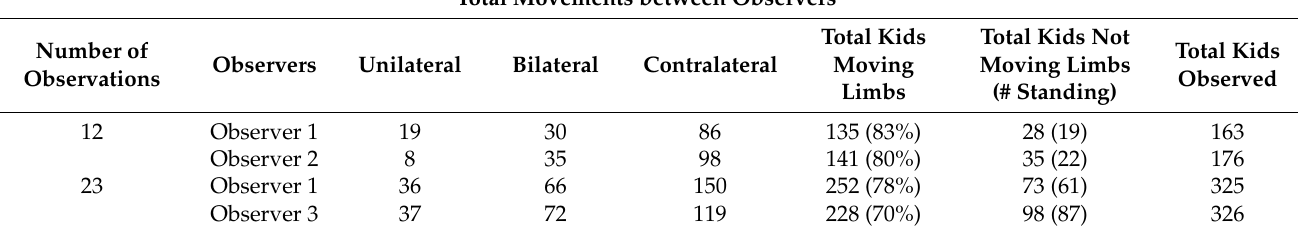
Table 2. Summary of Movement Patterns